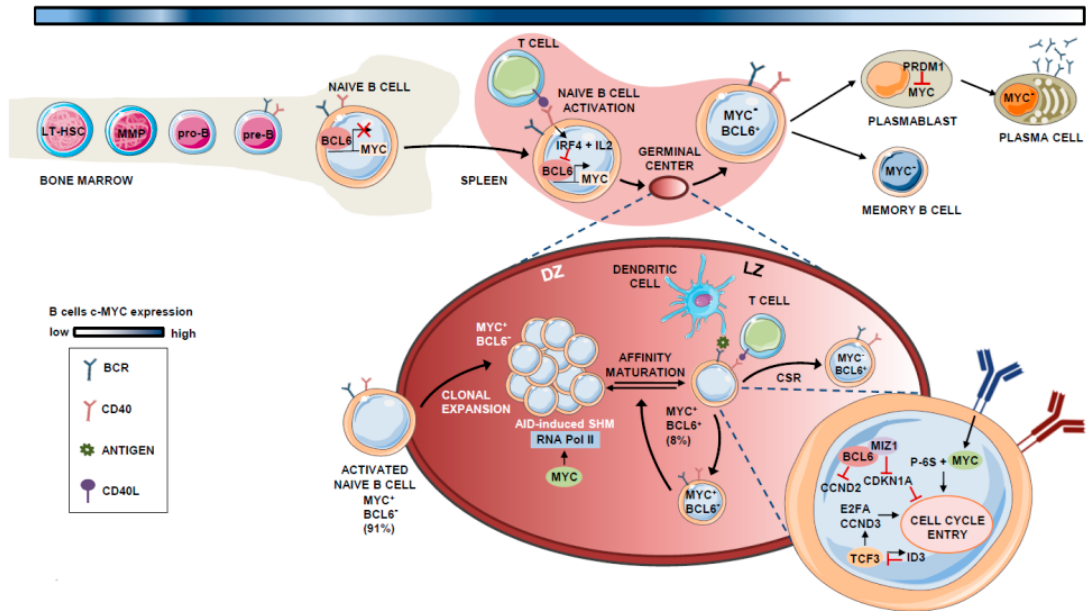
Figure 1. Expression and role of MYC in B lymphocyte differentiation. Schematic representation of the participation of the MYC protein throughout B ‐ cell differentiation in the bone marrow and germinal center (GC). The percentages shown refer to the population of MYC + , BCL6 +/ − cells in the total number of B cells present in the GC. The blue ‐ colored line at the top of the Figure indicates the evolution of MYC expression, where darker blue indicates steps that require higher MYC levels.